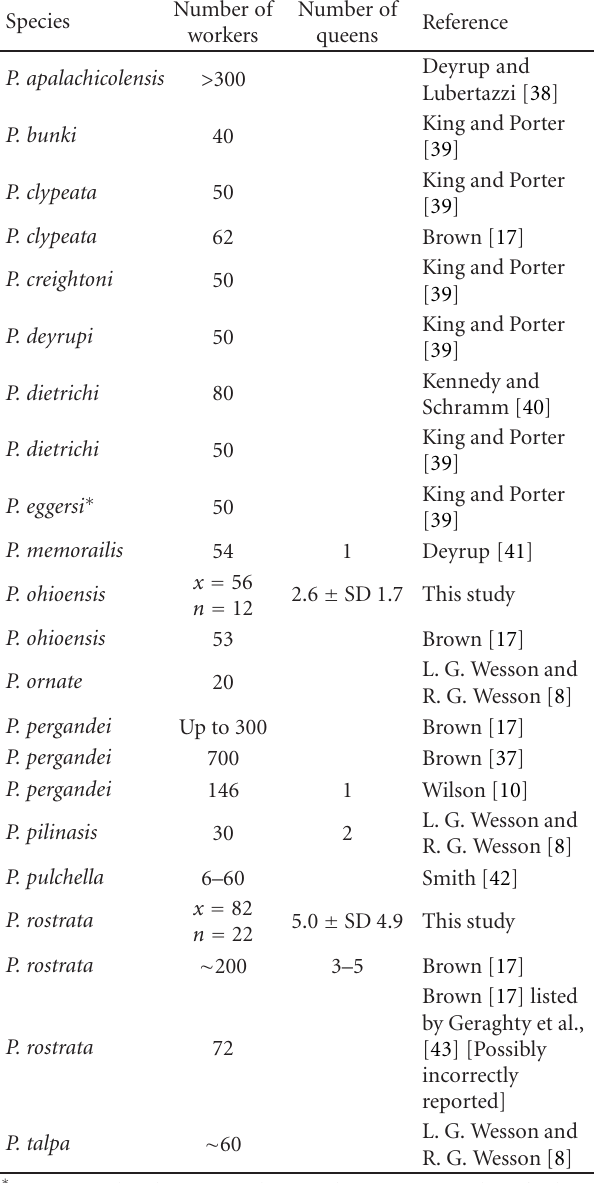
Table 3: Numbers of workers per colony of North American Pyramica species.